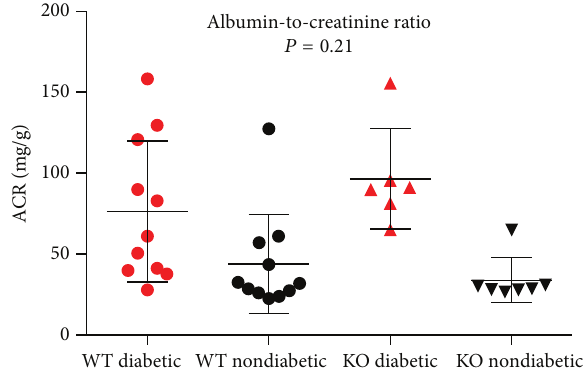
Figure 3: Albumin-to-creatinine ratio (mg/g) is illustrated for each of the four groups. The black error bars are illustrating mean ± standard deviation. WT: wild-type; KO: